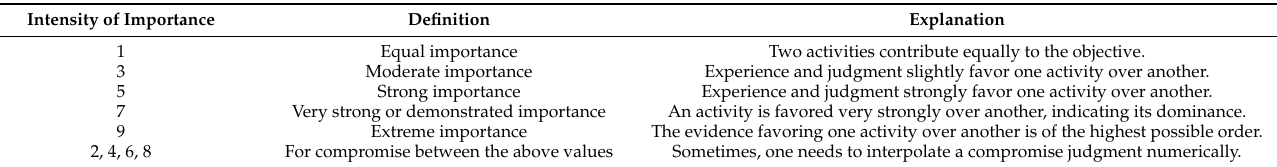
Table 2. Analytic hierarchy measurement scale [26].